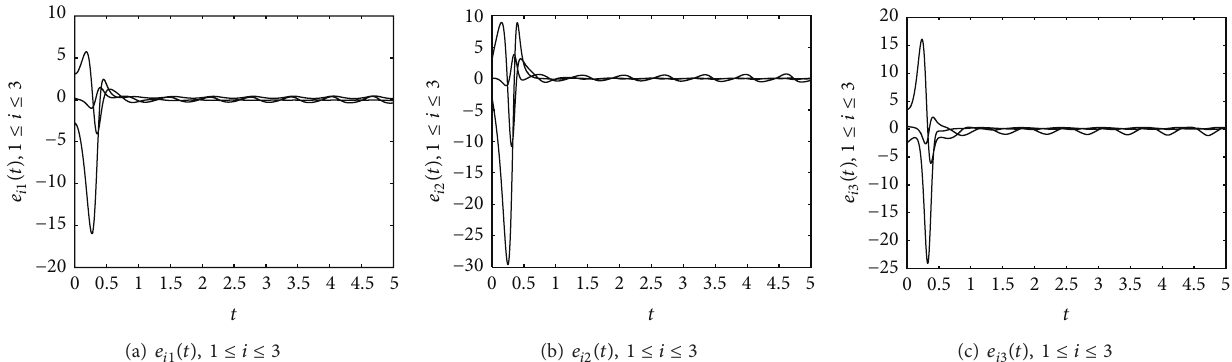
Figure 5: Synchronization errors between (30) and (28) by using adaptive controllers (26).